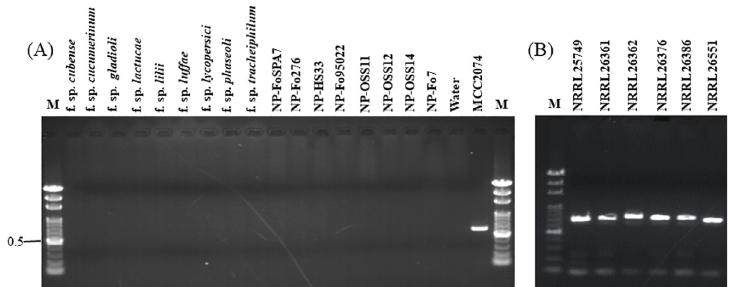
Fig 1. Specificity of the new designed primer pair. Agarose gels showing the amplification products from Polymerase Chain Reaction (PCR) using genomic DNA from isolates of 9 formae speciales , including cubense , cucumerinum , gladioli , lactucae , lilii , luffae , lycopersici , phaseoli and tracheiphilum , eight nonpathogenic strains of Fusarium oxysporum ( Fo ), and one Taiwan HOFo isolate MCC2074. (A)642 bp DNA product of Taiwan HOFo isolate MCC2074 amplified by the new primer pair Primer 5 and ST33-R. (B) Six reference isolates of HOFo from NRRL collection center could be detect and amplify a specific PCR product by Primer5/ ST33-R specific primers. The numbers on the left are the molecular weights (Kb) of the Gen-100 bp DNA ladder (GeneMark) (lane M).